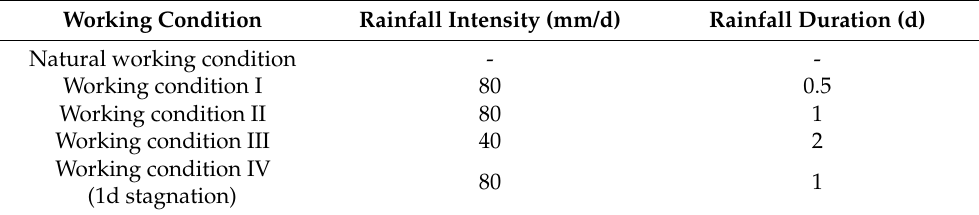
Table 2. Rainfall design table under different working